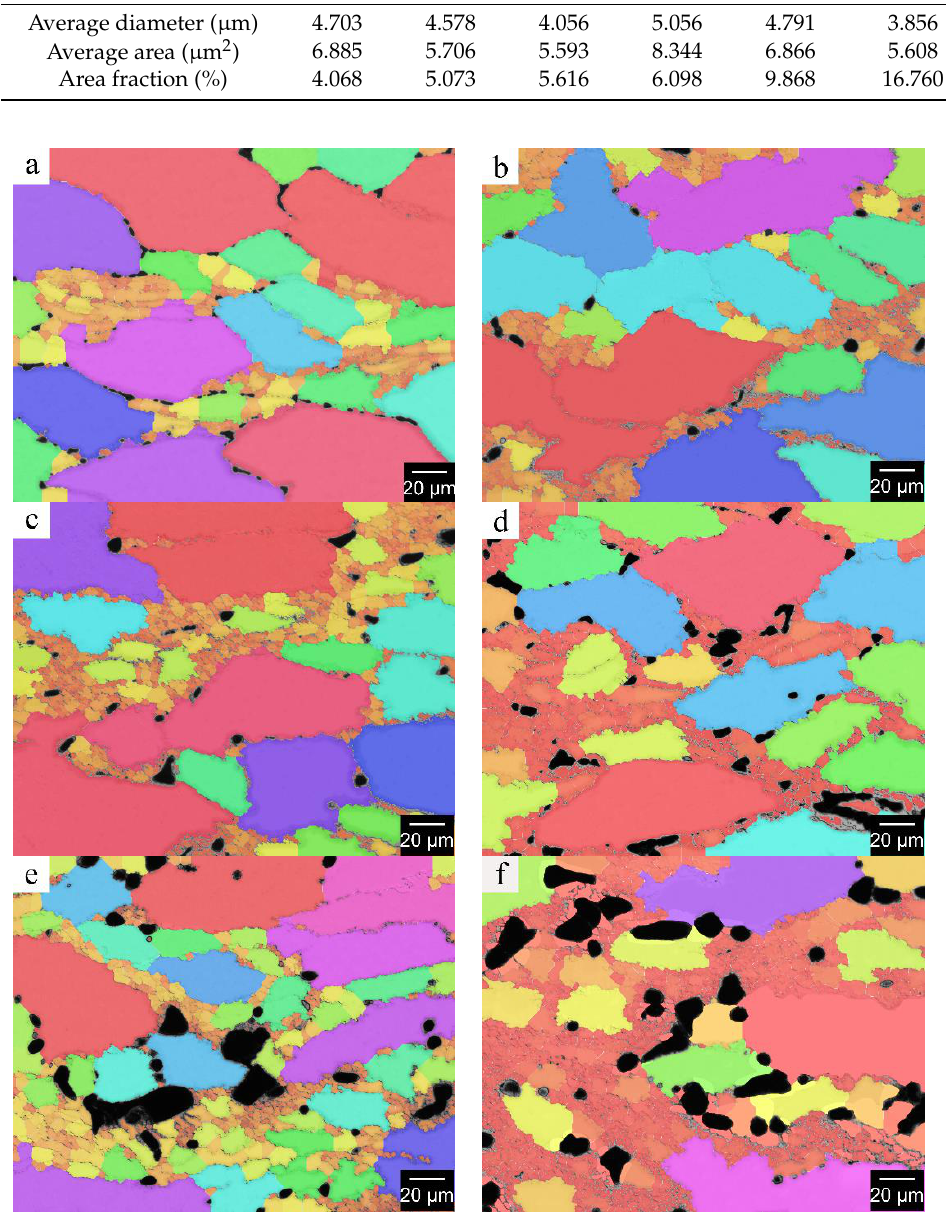
Figure 11. Recrystallization grain size and area calculation. ( a ) ZCI, ( b ) ZCII, ( c ) ZCIII, ( d ) ZCIV, ( e ) ZCV, ( f ) ZCVI . Table 5. Measurement results of recrystallized